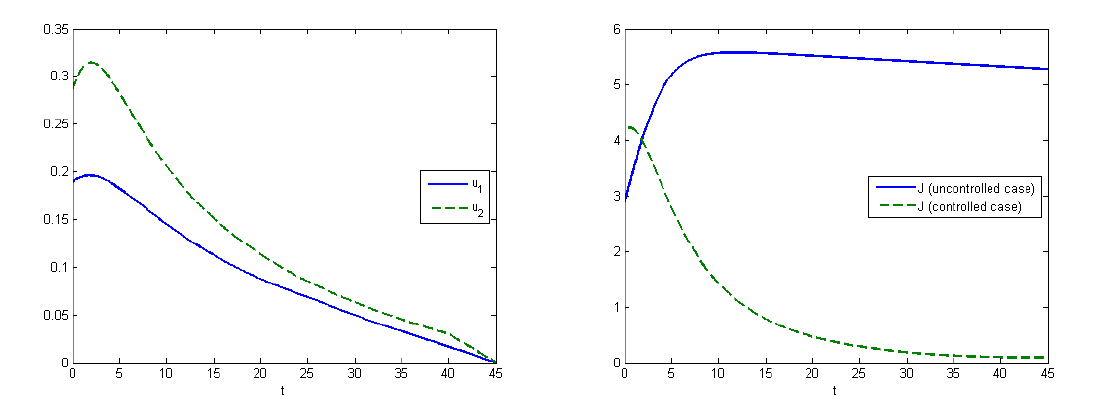
Figure 2. Experiment 1. Left : SIR model without virus mutation and without applying control. Initial states are I 1 ( 0 ) = 0.18, I 2 ( 0 ) = 0.32, maximum values are I 1 max = 0.3031 and I 2 max = 0.6742. Epidemic peaks a reached at 11th and 10th days. Right : SIR model without virus mutation with application of control. Vertical axes show the fractions of the subpopulations.